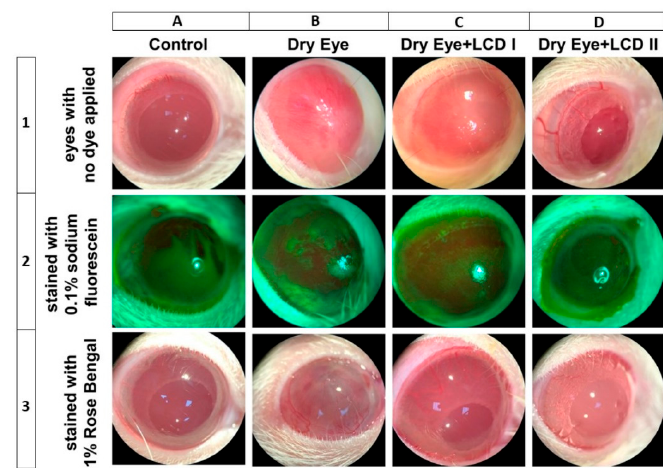
Figure 1. E ff ect of the combination of lutein / zeaxanthin, curcumin, and vitamin D (LCD) on Slit-lamp microscopic images of eyes in benzalkonium chloride (BAC) induced dry eye syndrome in rats. Control: No treatment; Dry Eye: BAC-induced dry eye syndrome; LCD I; Dry Eye + LCD I: BAC-induced dry eye syndrome plus LCD I (100 mg/kg body weight); Dry Eye + LCD II: BAC-induced dry eye syndrome plus LCD II (200 mg/kg body weight). Each representative vertical column contains the images of eyes from di ff erent groups ( n = 7 per group); Horizontal rows respectively from up to down contain images of eyes with no dye applied (upper row, 1), stained with 0.1% sodium fluorescein (middle row, 2) and stained with 1% Rose Bengal (lower row, 3). A normal ocular surface of the rat in the control group is shown in A1. The cornea is transparent and the details of the iris and pupil can be seen behind the cornea. No sign of inflammation and pathologic staining with sodium fluorescein (A2) and Rose Bengal (A3) was observed on the ocular surface of rat eyes belongs to the control group. Slit-lamp microscopy shows us more than 2 mm ciliary hyperemia and vascularized cornea of rat induced by BAC (B1). Iris and pupil are invisible due to the scar and vascularization. Di ff use staining with plaques (B2) and confluent spots (B3) are observed in stained corneas by sodium fluorescein and